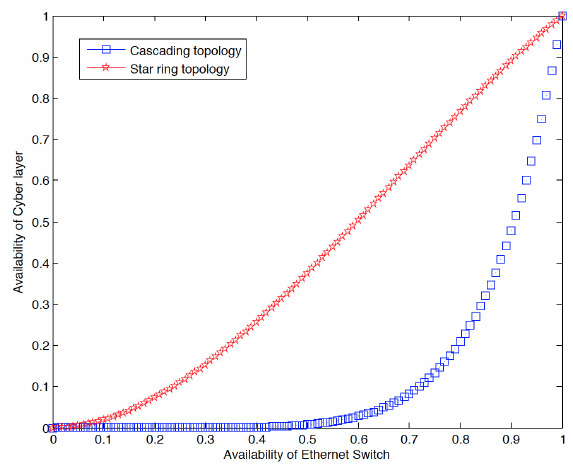
Figure 13. The sensitivity of Ethernet switches availability versus cyber layer availability.